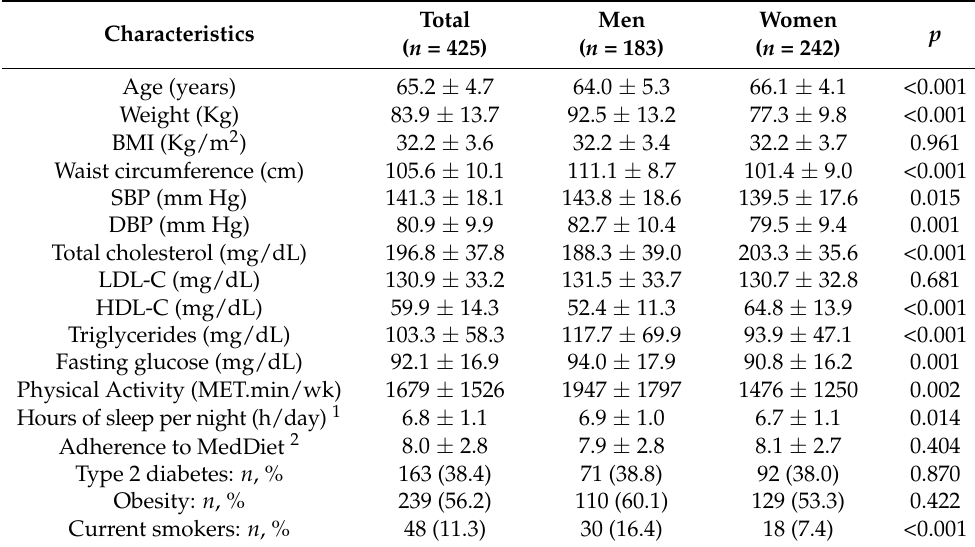
Table 1. Demographic, clinical, and genetic characteristics of the study population according to sex.